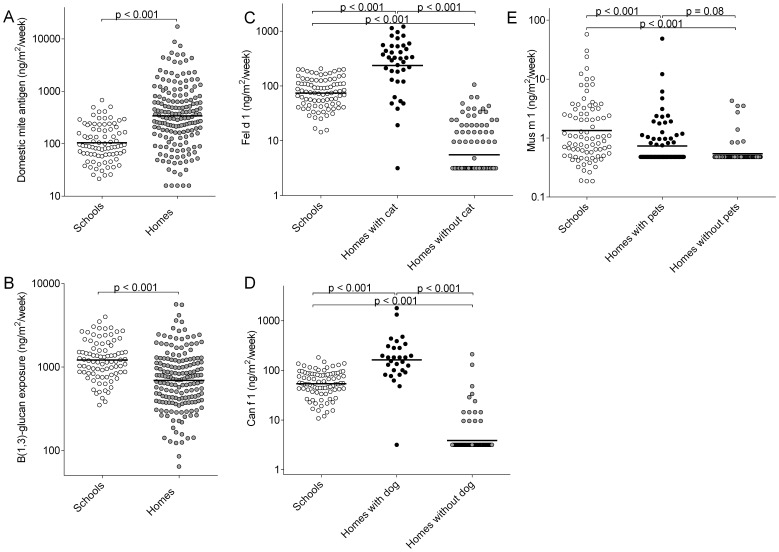
β-(1,3)-glucan and allergen levels in schools and homes in winter 2010.Measured levels of domestic mite antigen (A), β-(1,3)-glucans (B), cat allergen (C), dog allergen (D) and mouse allergen (E) in classrooms (n = 87, open circles) and bedrooms (n = 169, filled circles). Homes with and without pets are separately shown for the animal derived allergens.